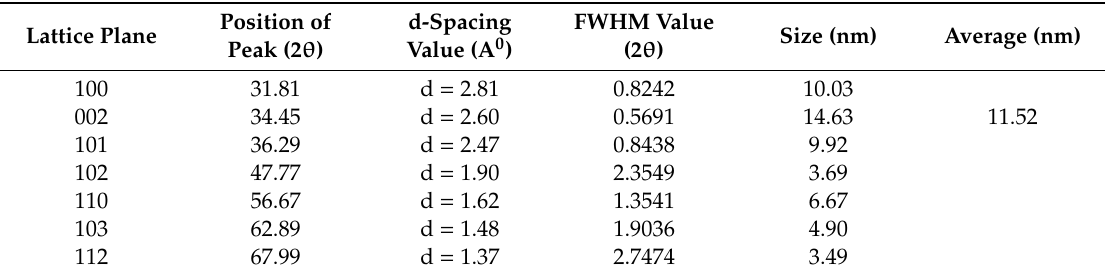
Table 2. Crystalline size analysis of DM -ZnO-Nps using an XRD analyzer. FWHM: full width at half maximum.